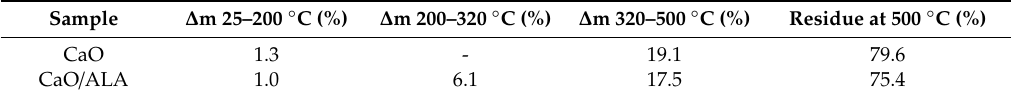
Figure 2. Differential thermogravimetric (DTG) curves for pure and ALA-modified CaO. Table 4. Mass losses obtained from thermogravimetric (TG) curves for pure and ALA-modified CaO (standard deviation: ∆ m ± 0.9%).